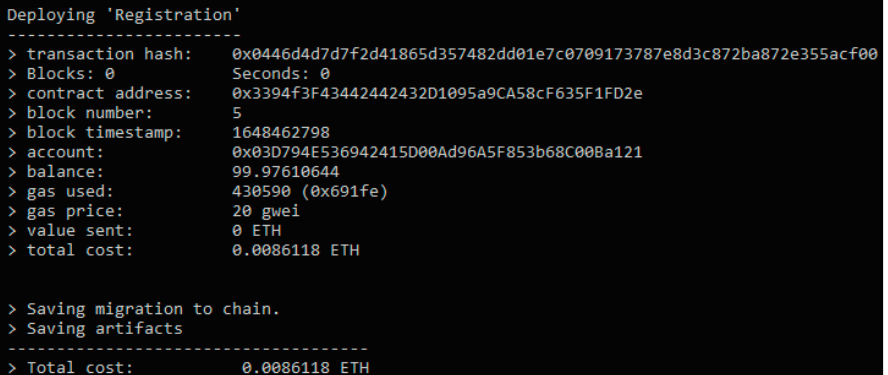
Figure 9. EMR smart contract deployment.